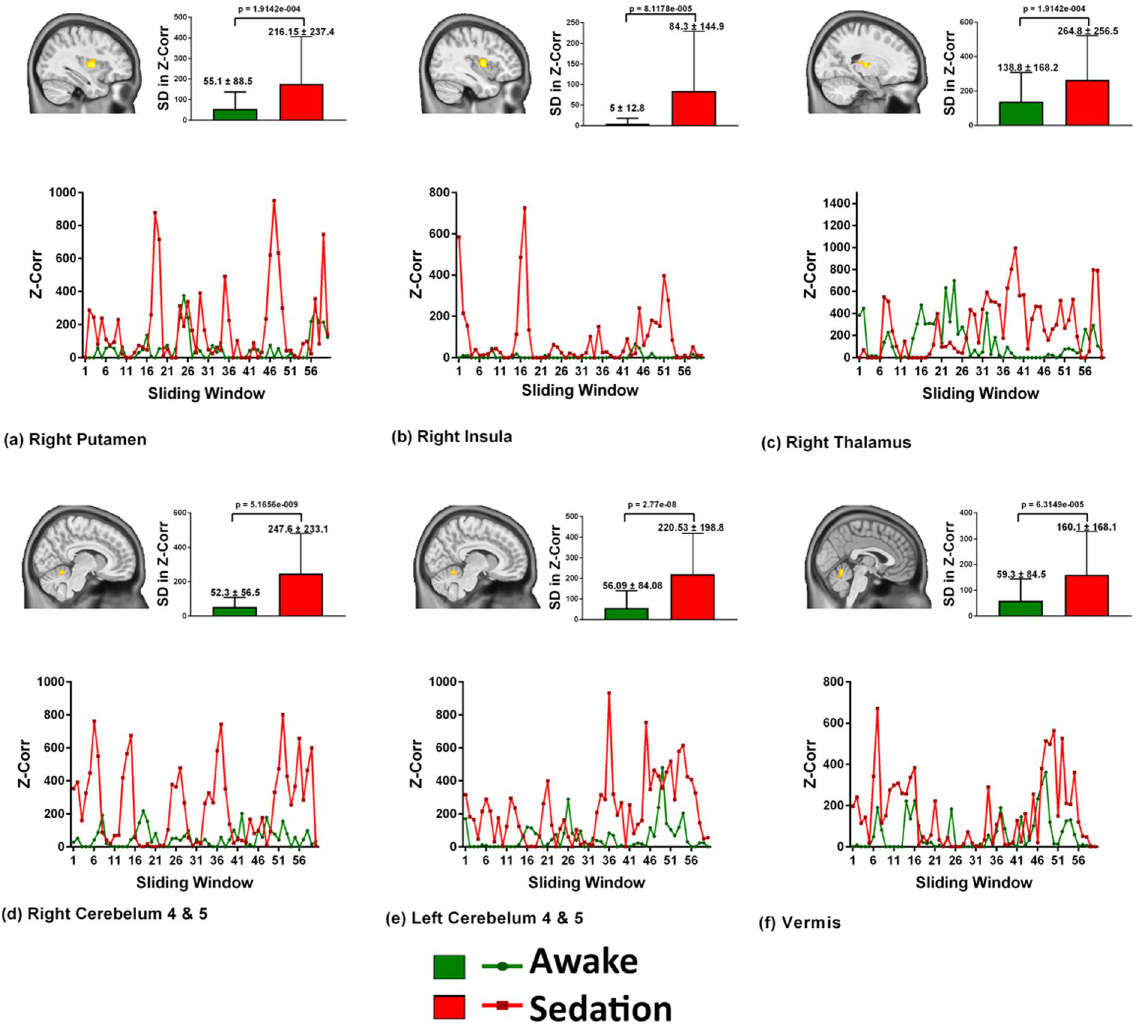
Figure 4. Connectivity fluctuations. Six representative deep nuclear and cerebellar regions which revealed an increased dynamic functional connectivity (DLC) during sedation is presented. The strength of the Z correlation on the Y-axis is plotted across the sliding window time points from 1 to 59 on the X-axis. The DLC during baseline awake state is depicted in green and during the sedated state is shown in red. The bar graph in the inset reveals the standard deviations (SD) in the Z correlation strengths during the two conditions. Significant sedation-induced increased connectivity involving the thalamus, basal ganglia and cerebellum with an increased SD demonstrating a “pulsatile” pattern with intermittent periods touching the zero line is most prominent in the cerebellum, basal ganglia and